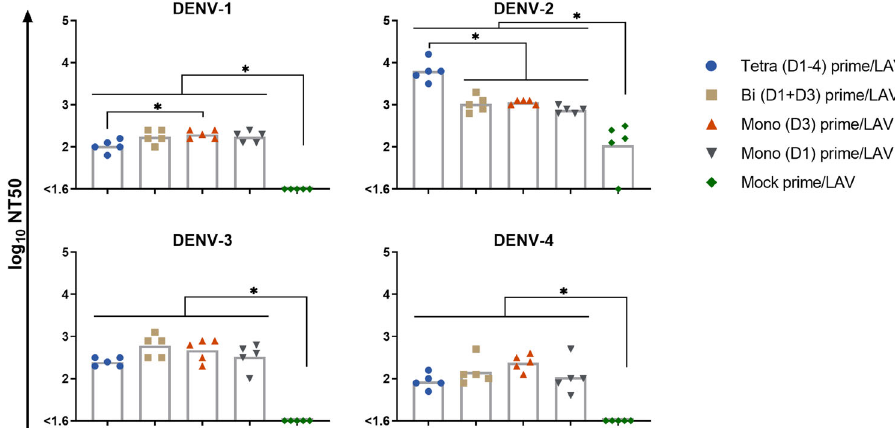
Fig. 7 Neutralizing antibody response following LAV vaccination. Blood samples collected on day 28 post LAV vaccination (study day 56) were assessed for the neutralizing antibody titer of each group against each DENV type. Neutralizing antibody titers are presented as log 10 - transformed NT50. The lowest dilution tested was 1/40. Bar heights are the geometric means for each group. Data were analyzed using a one- way ANOVA model with Tukey ’ s multiple comparisons test. * p <